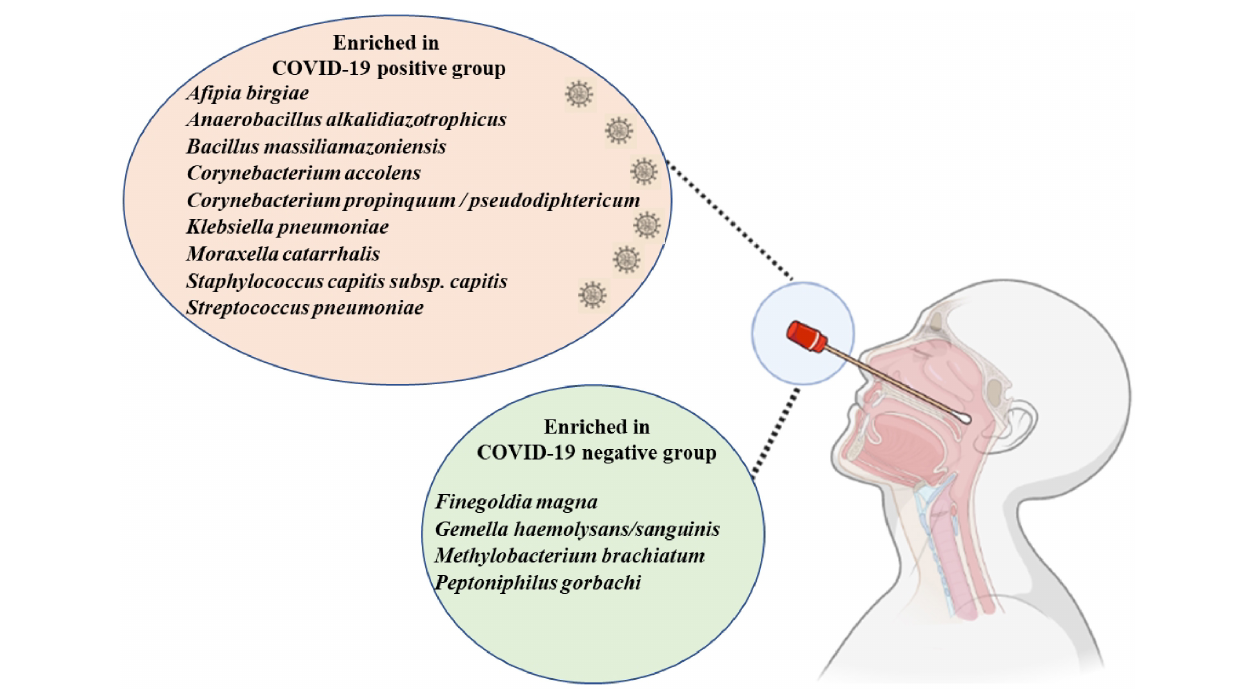
FIGURE 5 | The enriched nasopharyngeal microbiota bacteria in the COVID-19 positive group and COVID-19 negative group. Generated using Biorender